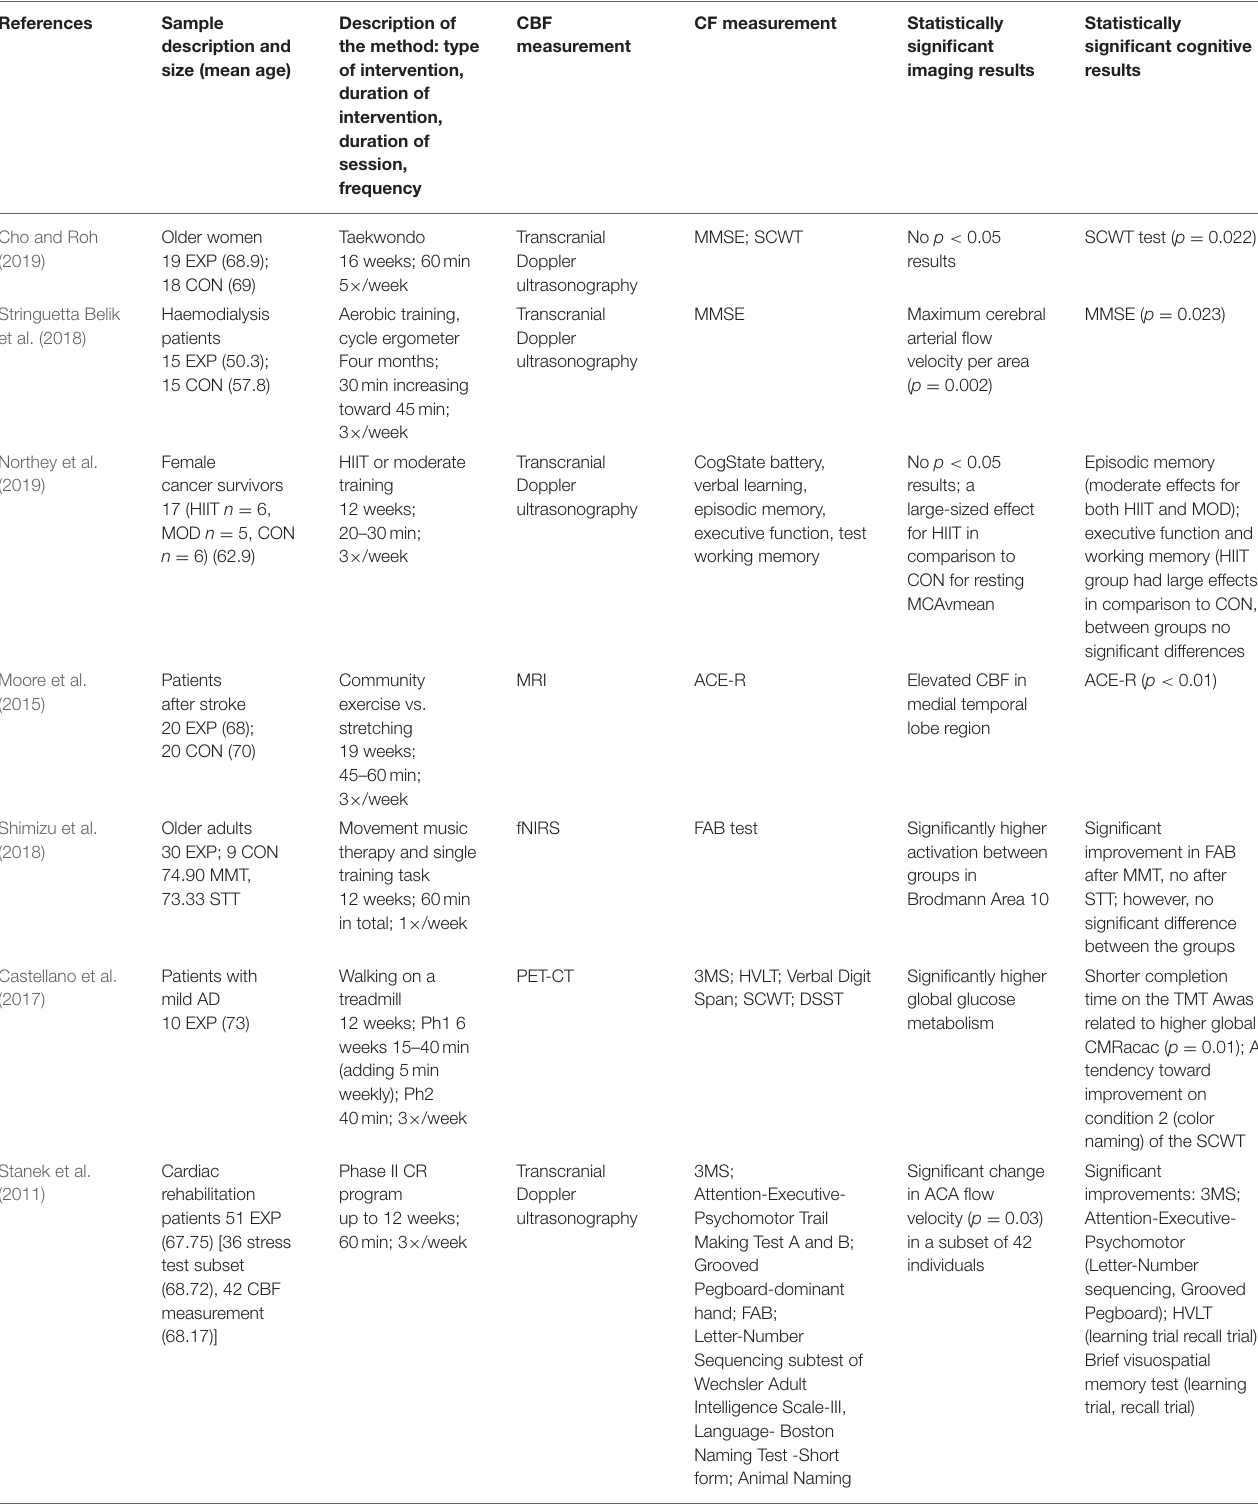
TABLE 2 | Summary of controlled exercise program